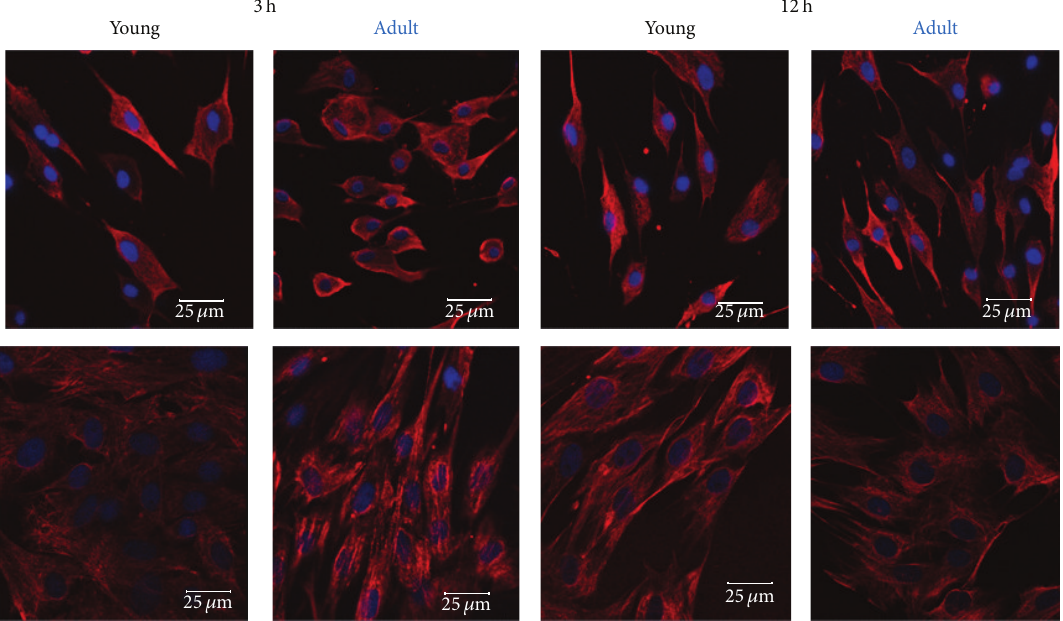
Figure 7: Expression of vimentin in undifferentiated and differentiated low passaged eBM-MSCs. Confocal microscopy shows the expression of vimentin (red) in neural crest-like cells from eBM-MSCs of young and middle-aged horses after 3 h and 12h of chemical induction. DAPI was used to stain the nuclei (blue). Respective undifferentiated controls are in the lower panel. Note the diffuse localization of vimentin, which is expressed in undifferentiated and in neural progenitor cells. Scale bar = 25 𝜇